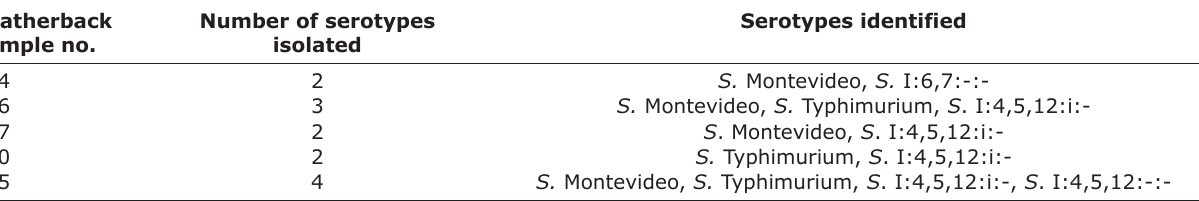
Table-2: Mixed Salmonella enterica serovars isolated from single cloacal cultures from leatherback turtles. Leatherback sample no.